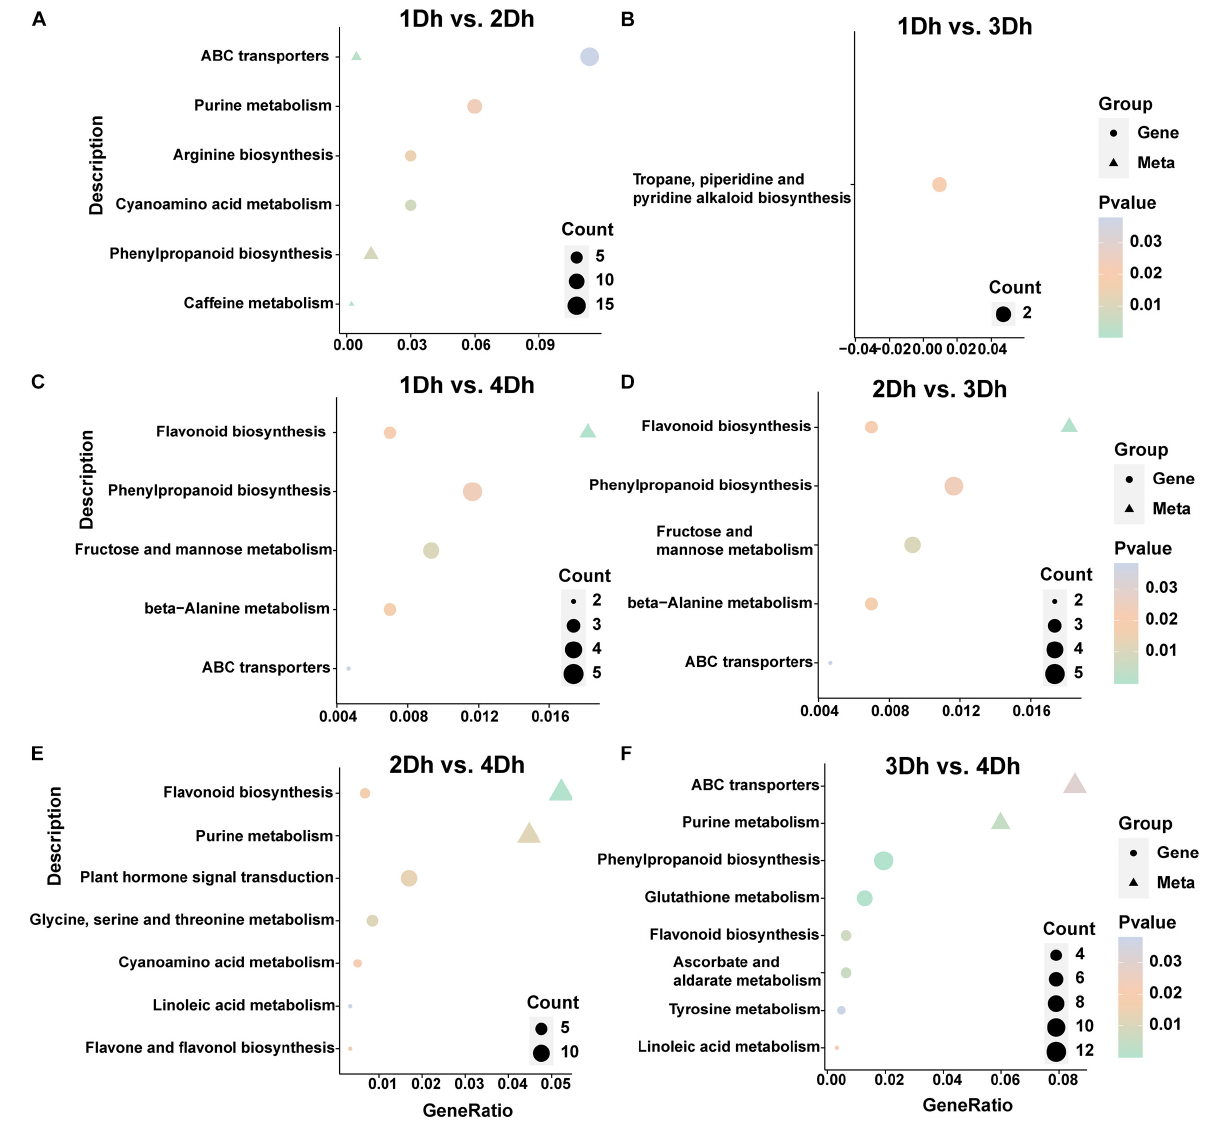
lightgreen, lightyellow, magenta, midnightblue, pink,